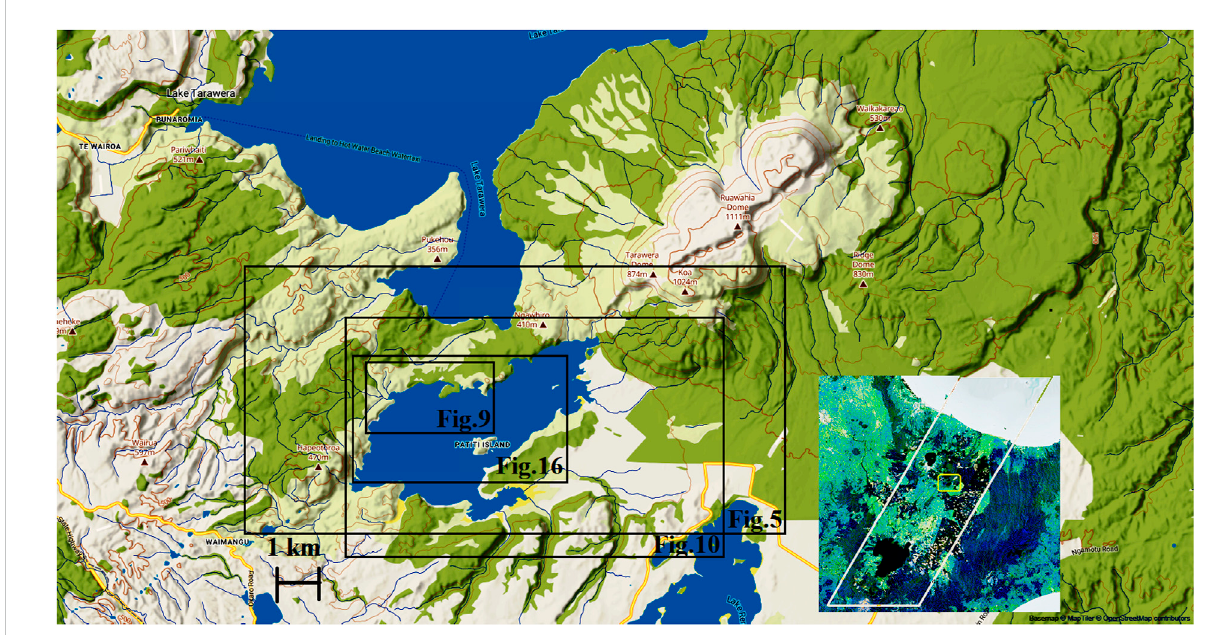
FIGURE 1 Inthe Rotomahana Basin within theTaup ō Volcanic Zone, the rift fromthe 1886 Mount Tarawera eruption passes southwest beneath the Wahanga, Ruawahia,andTarawerapeaksandthenewcraterLakeRotomahanabeforemovingtowardWaimangu.TheinsetmapoftherightsideoftheNorthIsland positionstheRotomahanaBasin(insetyellowrectangle)insidetheTaup ō VolcanicZone(insetwhitepolygon).ThemapsinFigures5,9,10,and16arealso inset in Figure 1 as black rectangles with the matching fi gure numbers in the right lower corners for reference (River